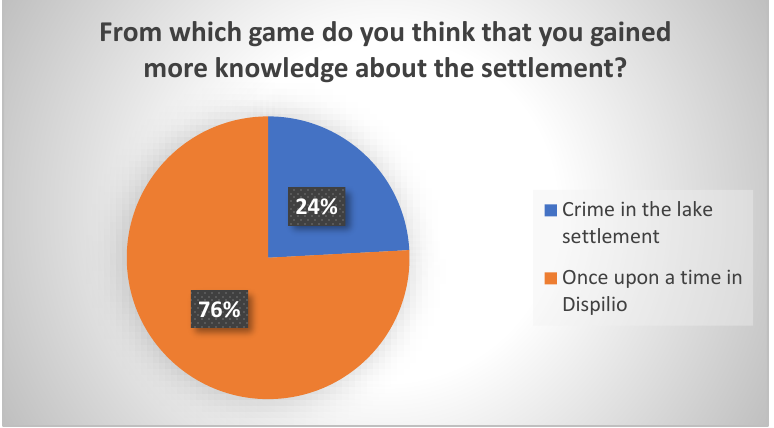
Figure 25. The storytelling game was again found to be more fun and engaging.